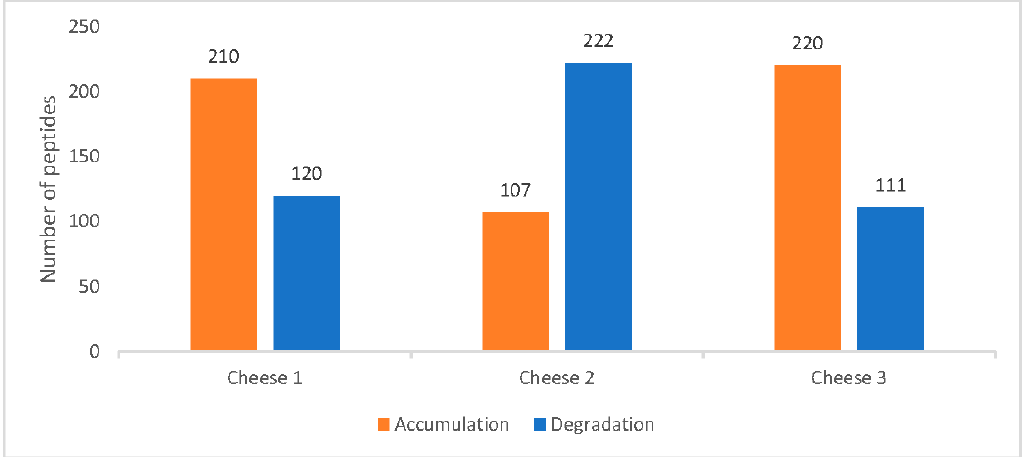
Figure 3. Cheese peptide profile trends between Days 0 and 90.